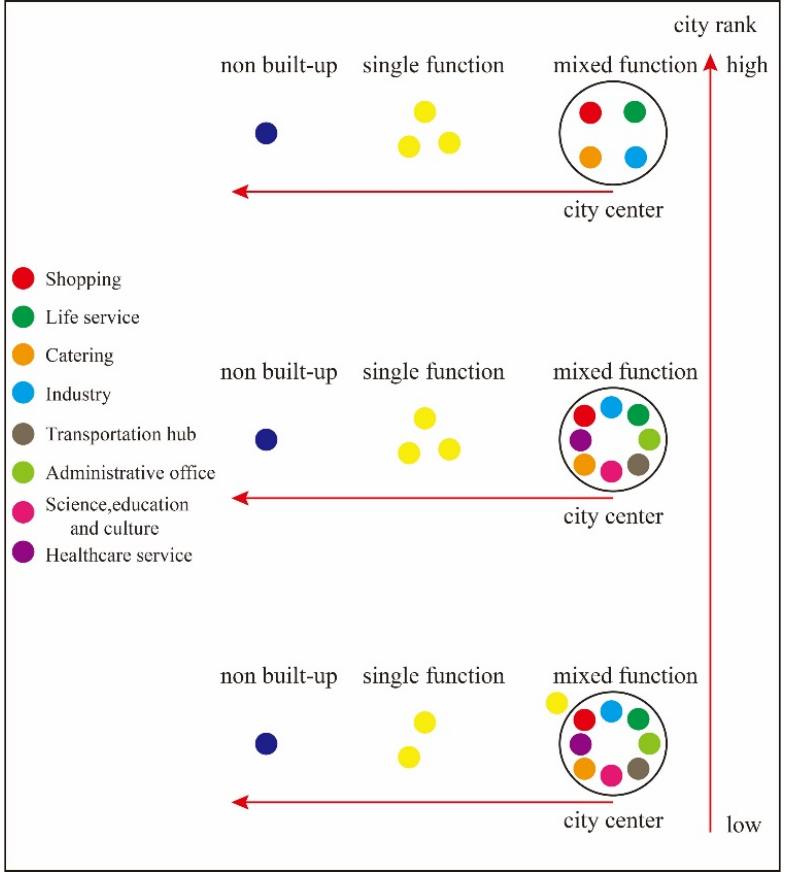
Figure 7. Spatial correlation pattern in Chinese urban agglomeration.